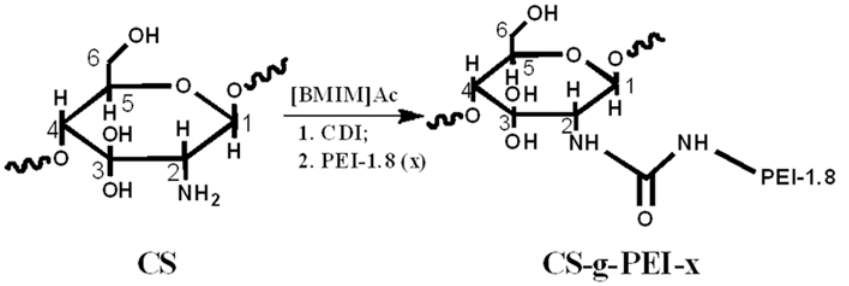
Fig 1. Grafting PEI-1.8 to CS via CDI to synthesize CS- g -PEI in